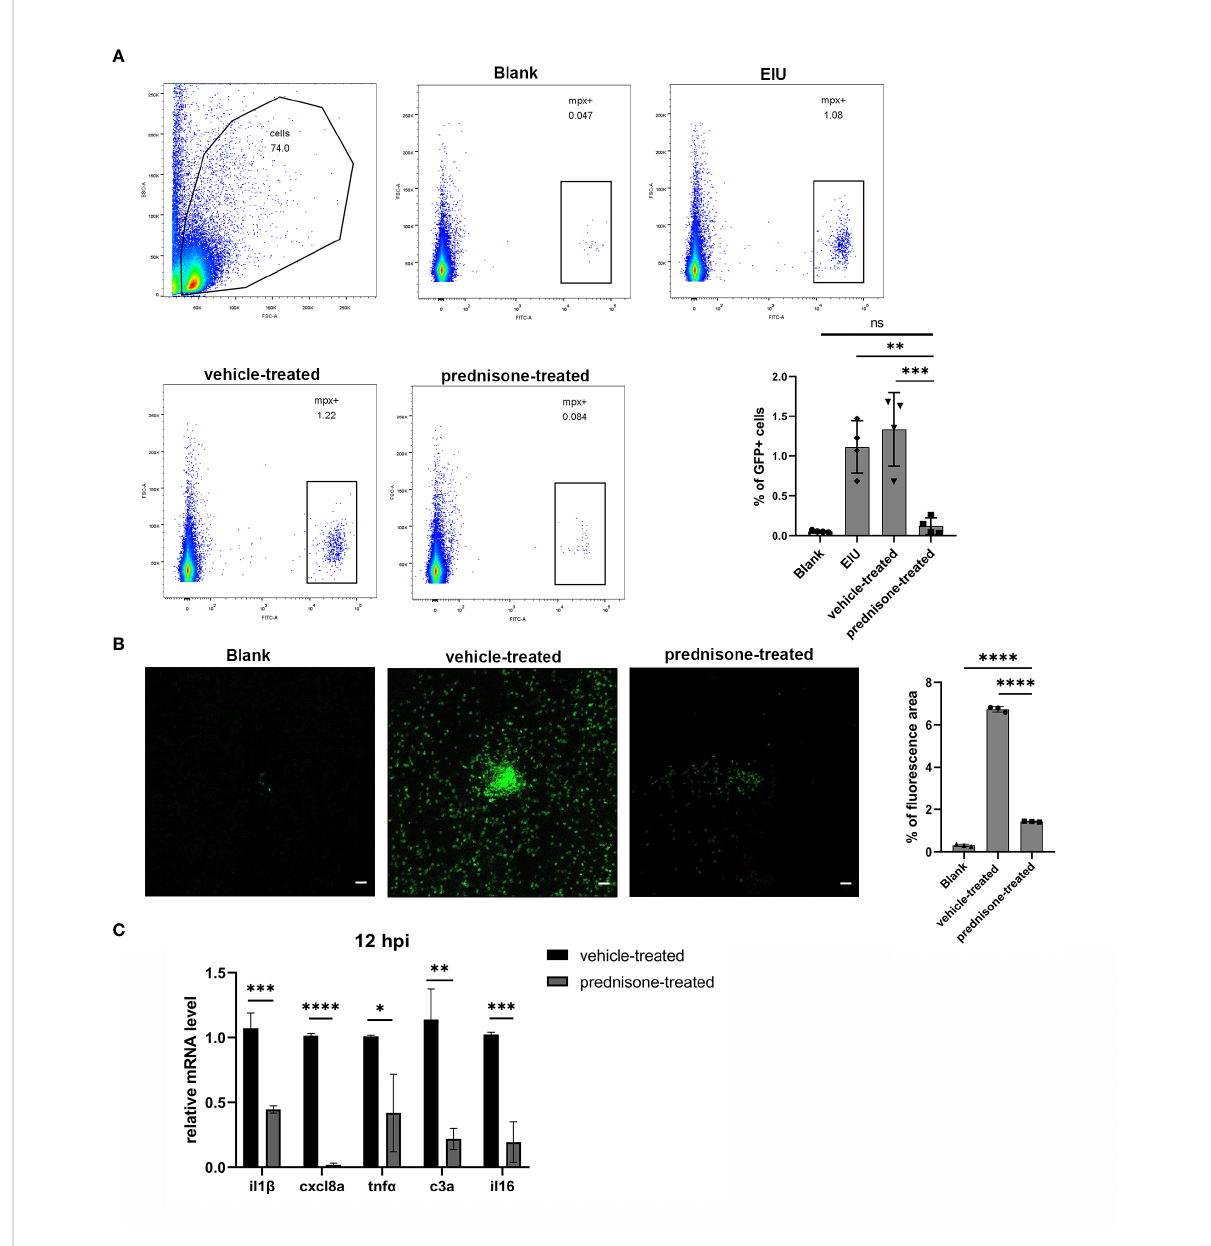
FIGURE 5 Prednisone immersion treatment inhibited EIU in fl ammation in zebra fi sh. (A) Live cells were separated out from the retina cell suspensions of Tg (Mpx:GFP) line. Left, Flow cytometry was used to analyze the GFP-positive neutrophils. Right, quanti fi cation of percentages of GFP-positive cells in different conditions (n = 4 per group; mean ± SD; *** P < 0.001; **** P < 0.0001; ns, not signi fi cant; one-way ANOVA). (B) Left, fl at mounts of retina around the optic disc in Tg(Mpx:GFP) line. Scale bar, 20 m m. Right, quanti fi cation of the relative GFP-positive area in retinal fl at mounts in different conditions (mean ± SD; n = 3 retinas per group; **** P < 0.0001; one-way ANOVA). (C) Transcript levels of proin fl ammatory genes of retina in zebra fi sh treated with 0.1% DMSO (vehicle-treated group) or 50 m m prednisone (mean ± SD; * P < 0.05, ** P < 0.01, *** P < 0.001, **** P < 0.0001; unpaired